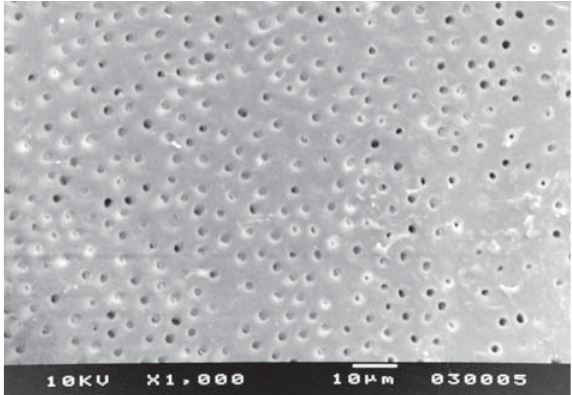
Figure 1- Scanning electron microscopy (SEM) micrograph of root dentin surface showing absence of smear layer and fully exposed dentin tubules, corresponding to score *(cid:11)=%>(cid:17)(cid:3)(cid:14)(cid:14)(cid:3)(cid:9)(cid:7)?(cid:11)=G(cid:29)(cid:28)(cid:31)(cid:31)(cid:31)(cid:11)(cid:8)(cid:5)(cid:20)(cid:9)(cid:16)#(cid:17)(cid:5)(cid:7)(cid:16)(cid:10)(cid:9)?